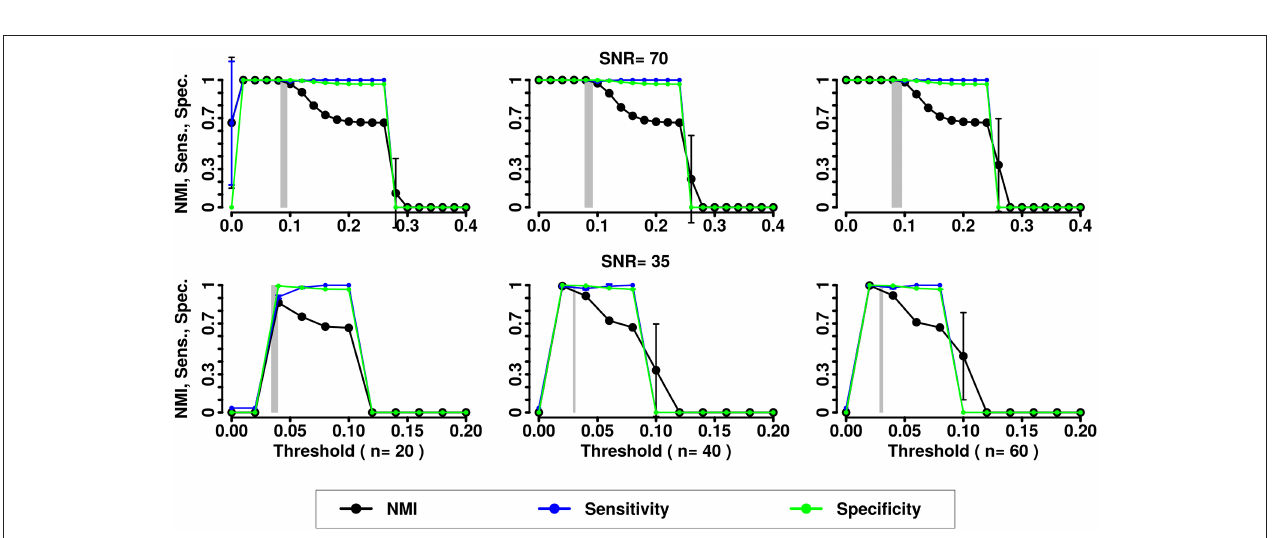
FIGURE 6 | NMI (in black), Sensitivity (in blue), and Specificity (in green) of the InfoMap community detection algorithm applied to LFR networks ( µ t = µ w = 0.2). Two different signal to noise ratio (SNR) are represented on the lines (top line SNR = 70, lower line SNR = 35), Number of subjects varies depending of the column (respectively from left to right 20, 40, and 60